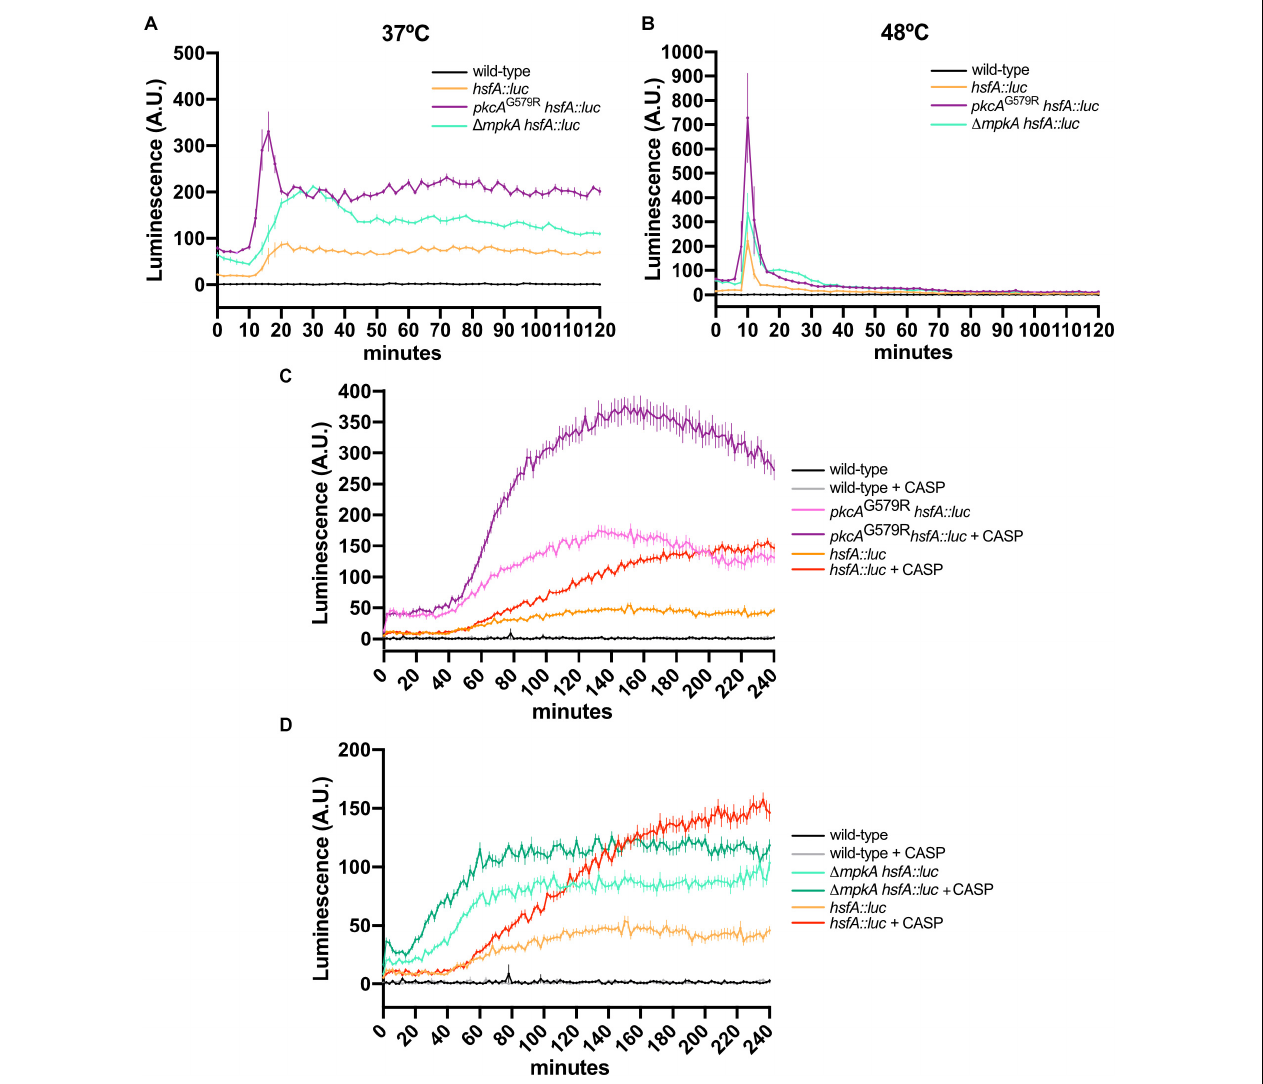
FIGURE 6 | The loss of function of CWI regulators increases HsfA expression in A. fumigatus biofilms under HS and cell wall stress. (A,B) Luciferase activity assay of the hsfA::luc , pkcA G 579 R hsfA::luc , and (cid:49) mpkA hsfA::luc strains during the HS at 37 ◦ C (A) and 48 ◦ C (B) . (C,D) Luciferase activity assay of the pkcA G 579 R hsfA::luc (D) and (cid:49) mpkA hsfA::luc strains during cell wall stress caused by CASP. The wild-type strain without luciferase gene was used as the negative control in all experiments. Mean ± SEM ( n ≥ 8) are shown. The results were normalized by the number of conidia (2 × 10 5 per assay) and are expressed as luminescence (arbitrary units). CASP: caspofungin (2 µ